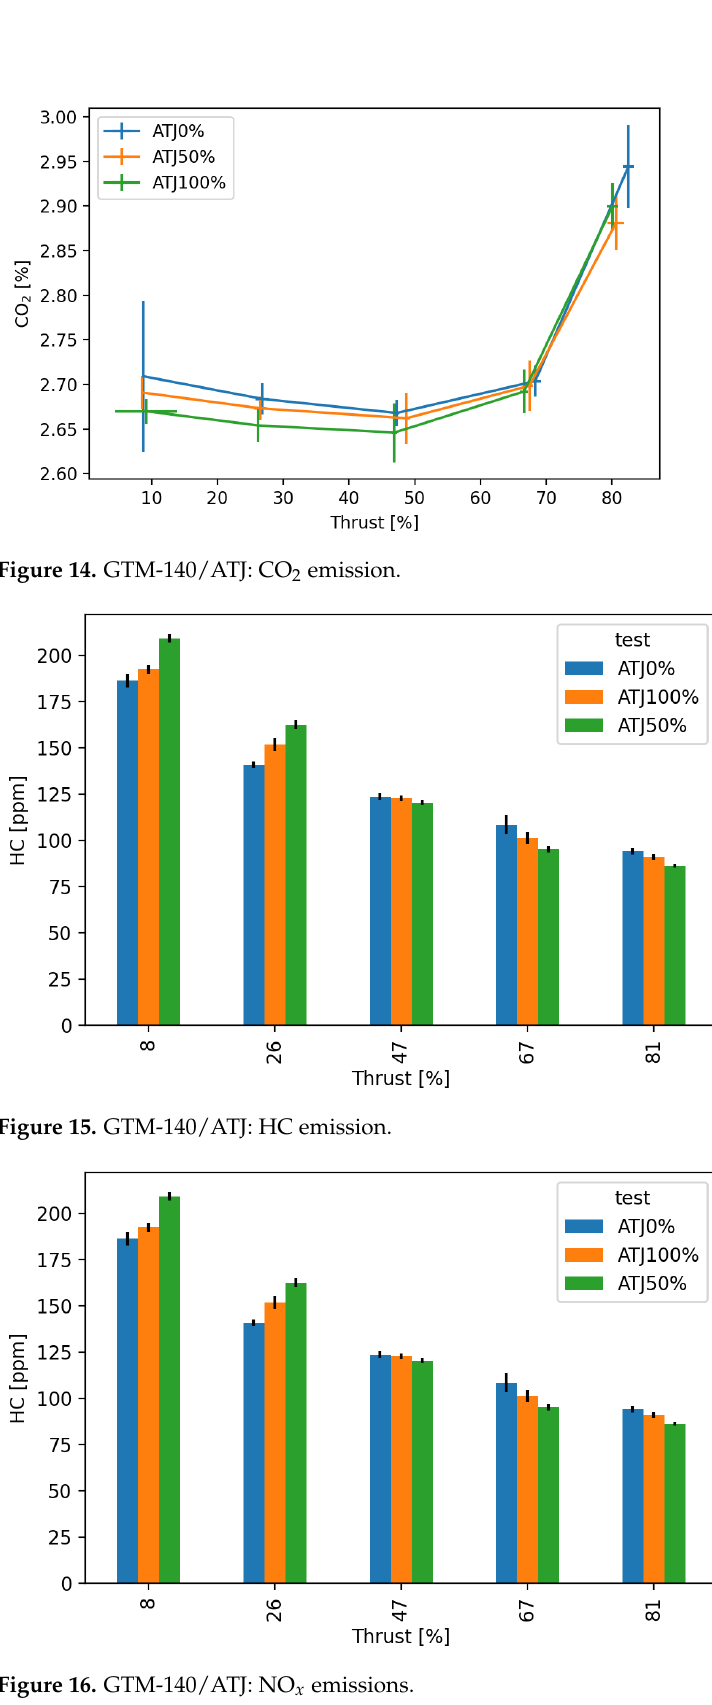
Figure 16. GTM-140/ATJ: NO x emissions.